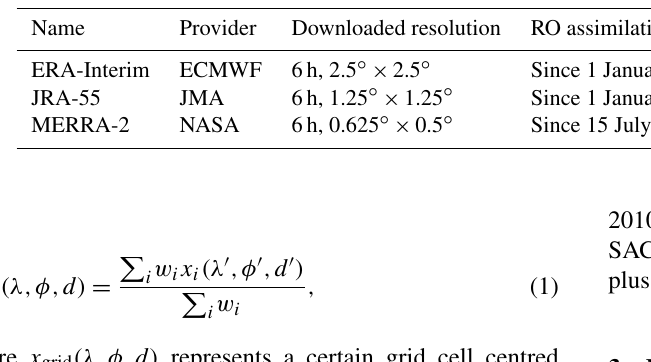
Table 1. Summary of reanalysis products, their resolution, assimilation of GPS RO data, and reference